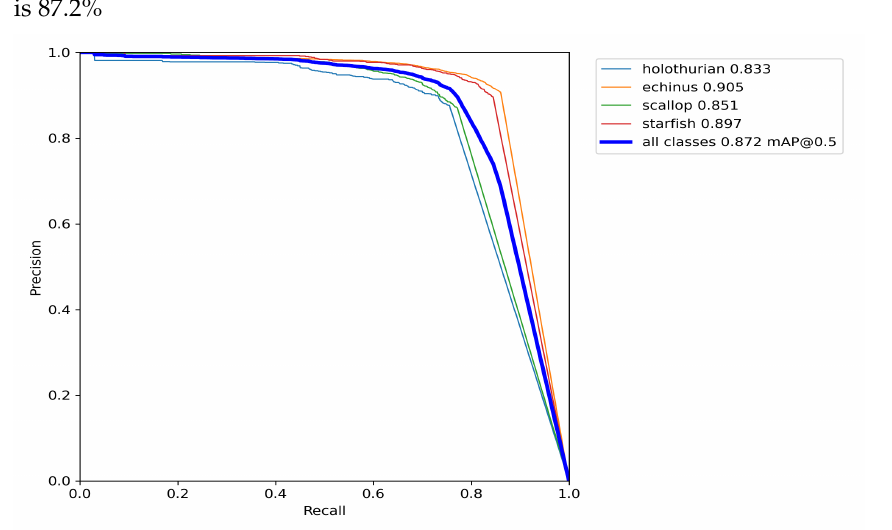
Figure 10. The precision-recall curve of the improved